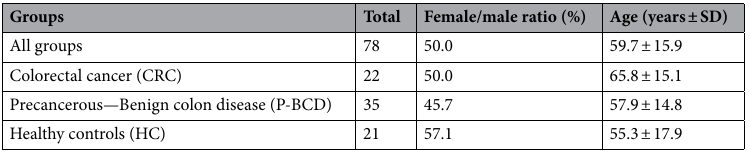
Table 1. The study groups and patient characteristics.